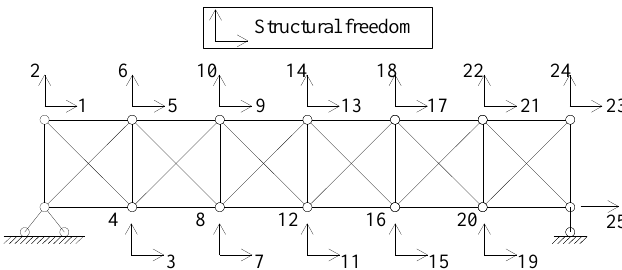
Figure 5. Structural freedom of the plane truss.